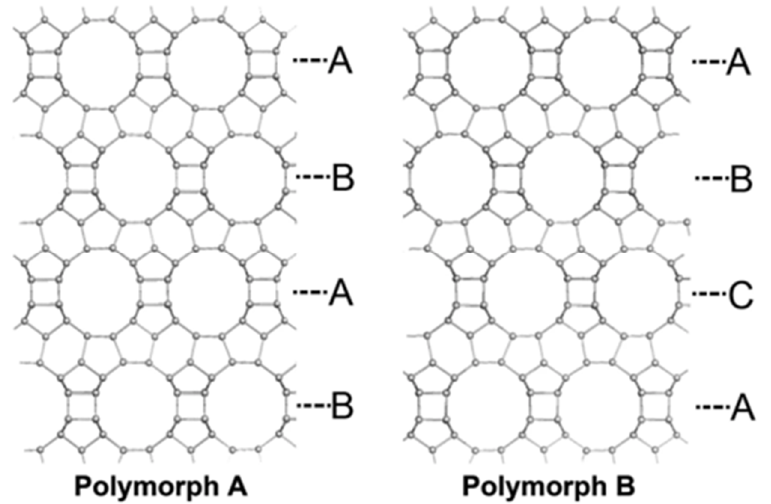
Figure 5. Top view of polymorph A and polymorph B, showing their distinctive stacking order. Reprinted with permission from [79] Copyright 2015 Scientific Reports.